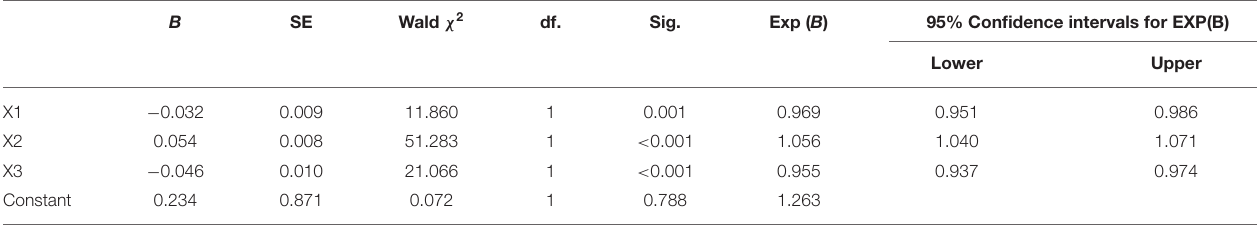
TABLE 5 | Variables in the regression